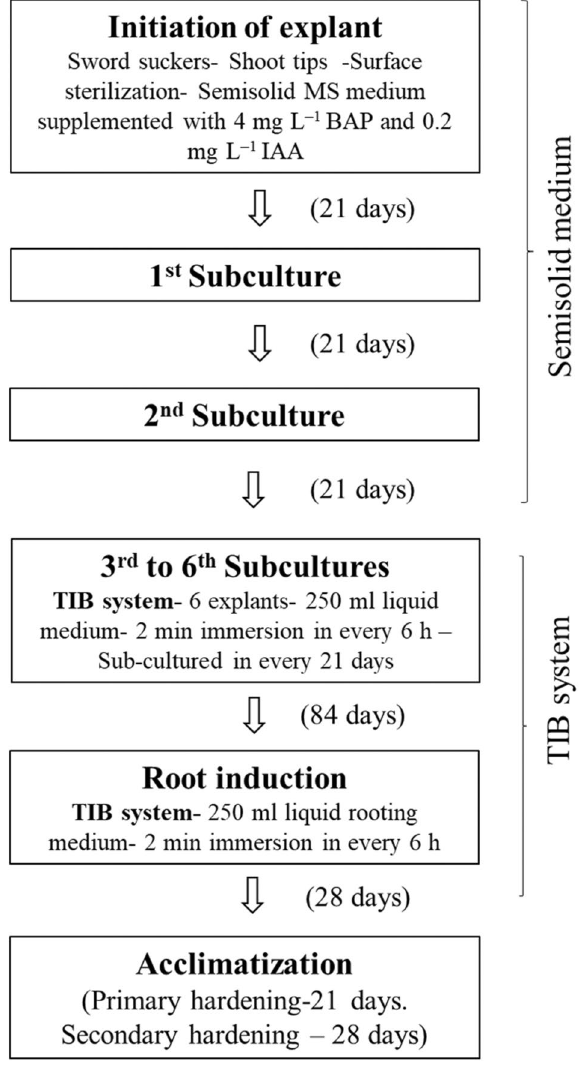
Figure 9. Schematic representation of large-scale in vitro plantlet production in